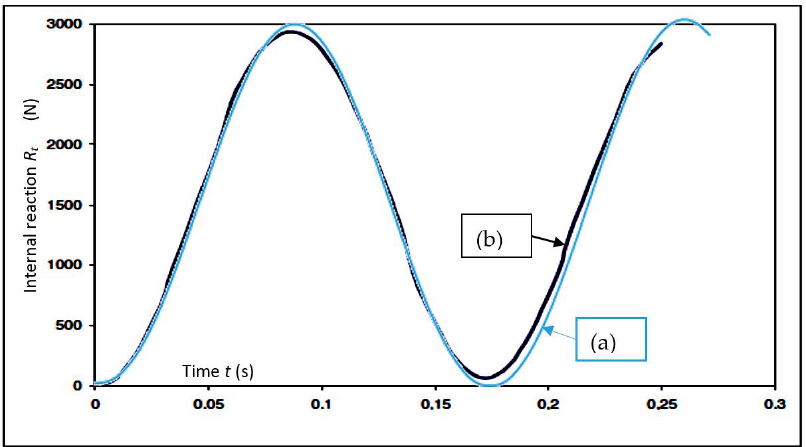
Figure 13. Results for the vibration of a single degree of freedom (SDOF) system with the pneumatic spring in analysis: ( a ) with Newmark’s method (natural period is ∼ = 0.180 s); and ( b ) with a pseudo-dynamic simulation (natural period is ∼ = 0.175